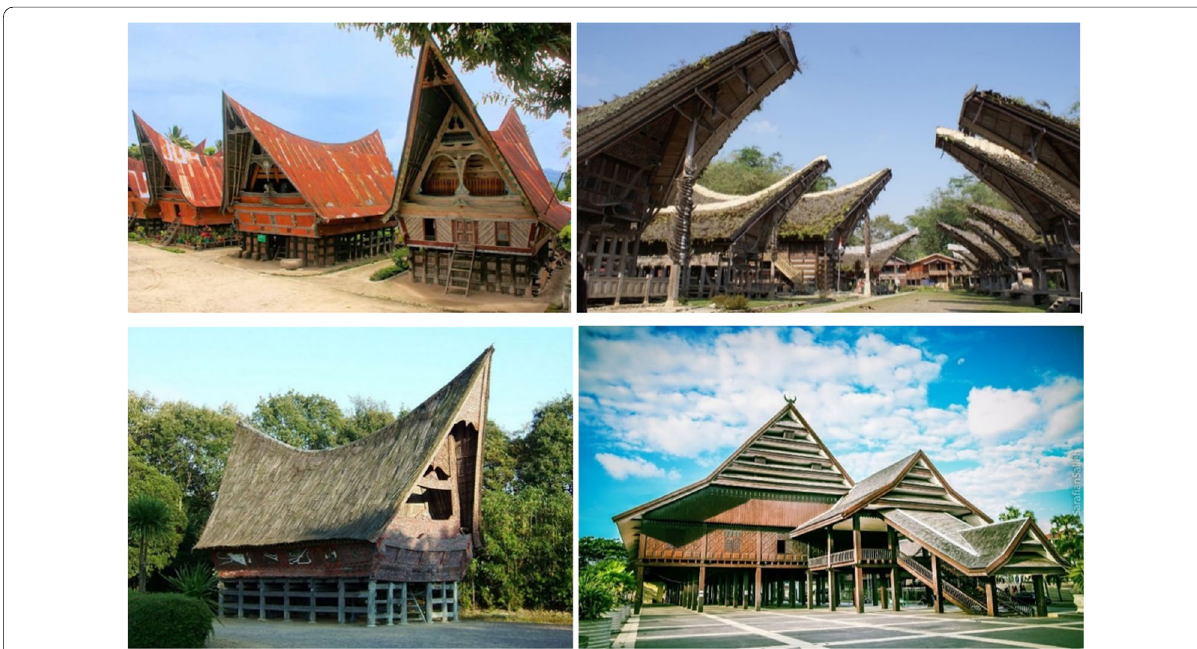
Fig. 4 Common Natural Building Material in Indonesian Vernacular Architecture. Source: https:// www. re- think ingth efutu re. com/ fresh- persp ectiv es/ a1232- verna cular- archi tectu re- of- indon esia/, downloaded on June 26, 2021